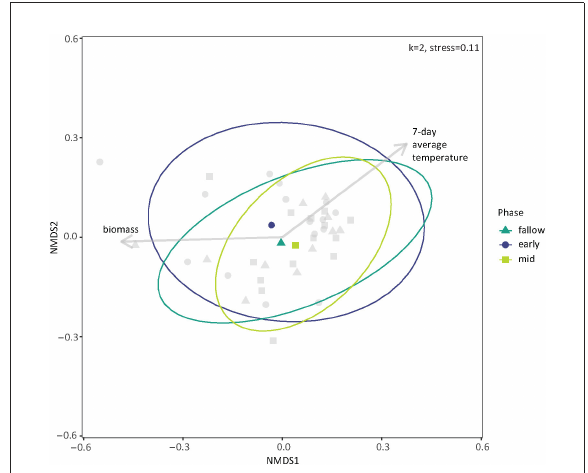
FIGURE4 Ordination of soil bacterial communities in 2019 by presence and composition of cover crops using non-metric multidimensional scaling (NMDS) on weighted Bray-Curtis dissimilarities. The centroids and multivariate t-distribution ellipses for bacterial communities are designated by color and shape (circle for early season, triangle for fallow, and squared for mid-season). Plant biomass and average soil temperature for the 7 days preceding or including sampling were found to be potential vectors for the ordination. For the NMDS calculation, k = 2, and stress =